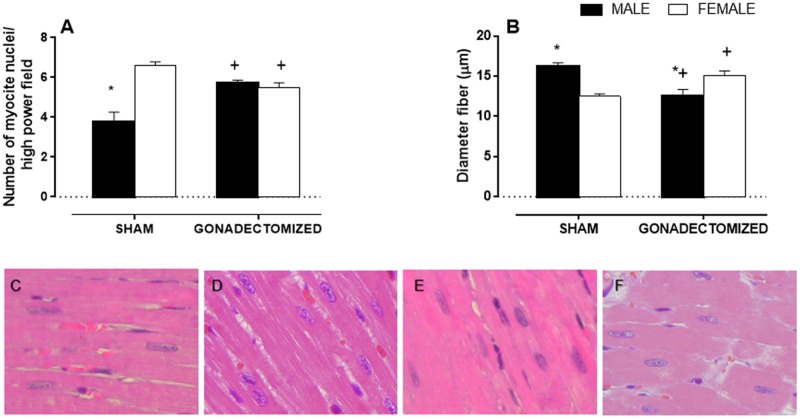
Histological analysis of the left ventricle in SHR.Sham and gonadectomized animals. A: number of myocyte nuclei/ high power field, B: cardiac fiber diameter. Representative images of histological analyses in C: sham male SHR, D: sham female groups, E: orchiectomized male groups and F: ovariectomized female groups. Samples were stained with hematoxylin/eosin (H&E): 400x. The results are the mean ± S.E.M. (n = 7 per group). Statistical significance is indicated by *P < 0.05 vs. females of the same group; +P < 0.05 vs. sham animals of the same sex; (two-way ANOVA and Fischer test).